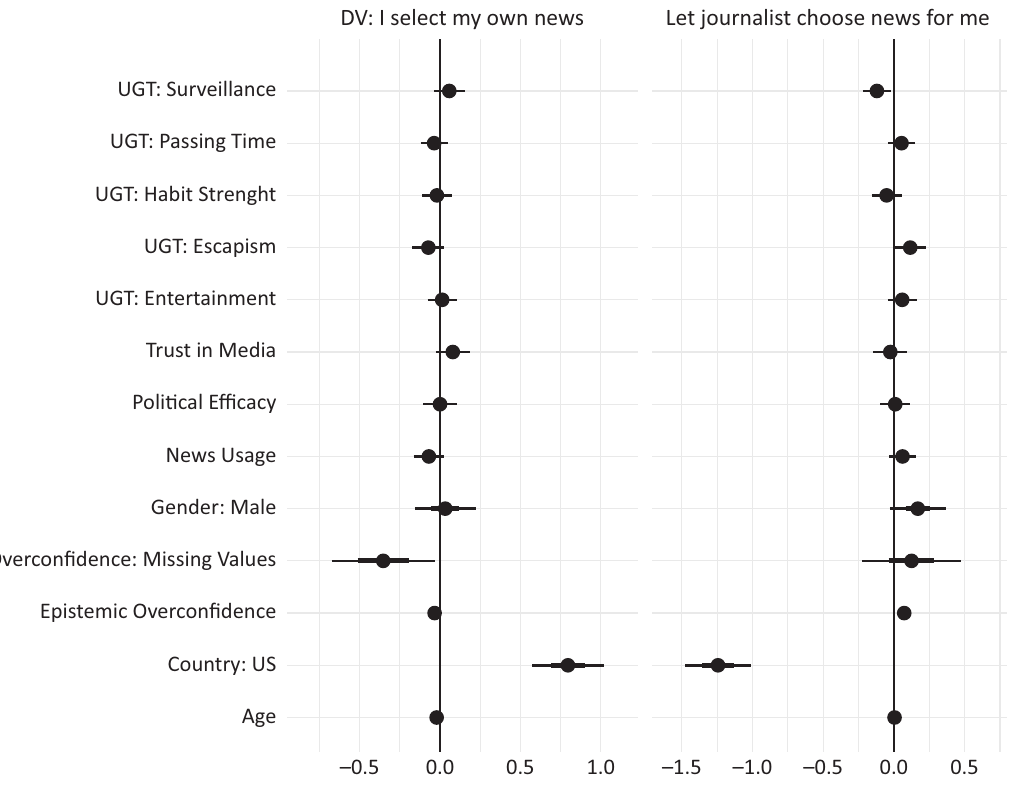
Figure 8. Predicting appreciation for other news